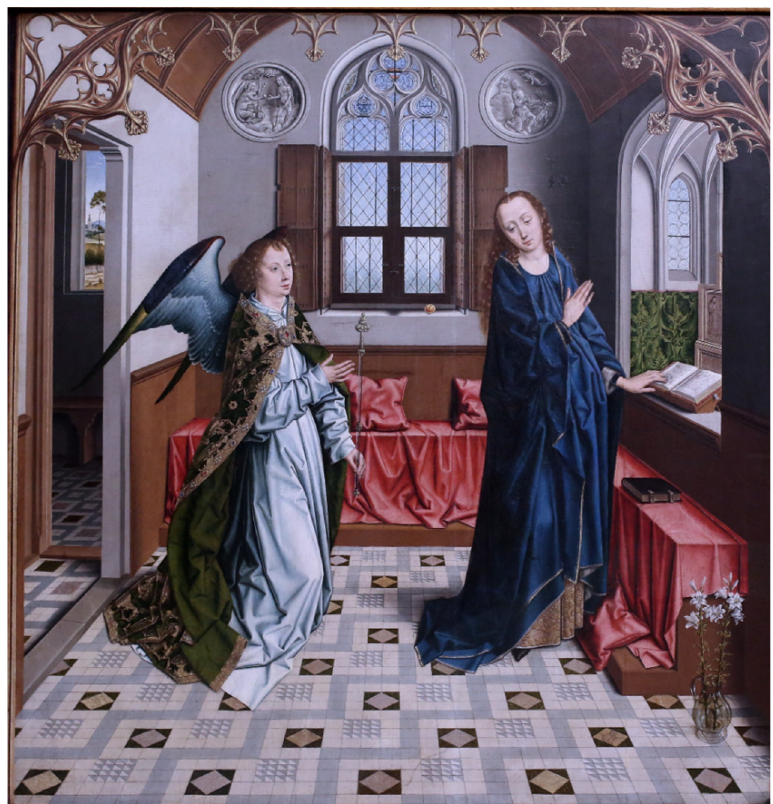
Figure 3. Albrecht Bouts, Annunciation , ca. 1500. Oil on oak, 116.8 × 109 cm. München, Alte Pinakothek. © München, Alte Pinakothek, https://res.cloudinary.com/tne/image/authenticated/s--pNAgos0D--/q_80/artworks/ALBERT-BOUTS_VERKUENDIGUNG-AN-MARIA_CC-BY-SA_BSTGS_WAF79.jpg (accessed on 29 October 2021). Image in the public domain.